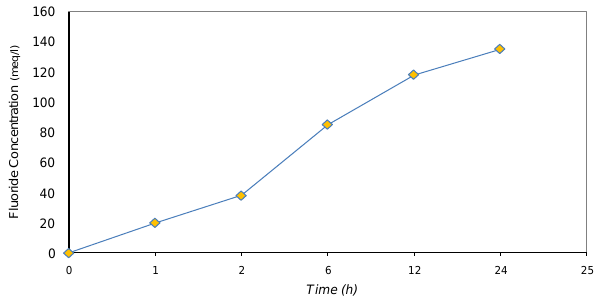
Fig. 17. A leaching test of a mantling ash sample conducted at ambient